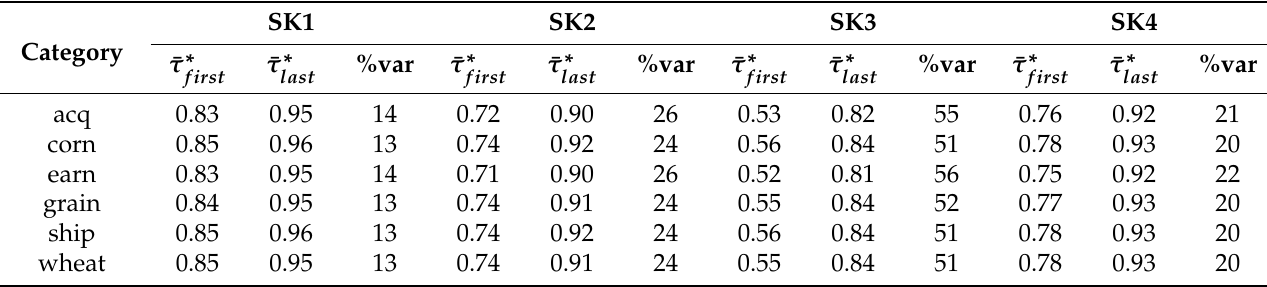
Table A5. Average of the computed collective concordance indices per category ( m =